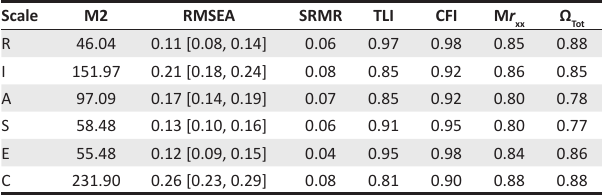
TABLE 1: RIASEC model fit statistics and reliability coefficients.